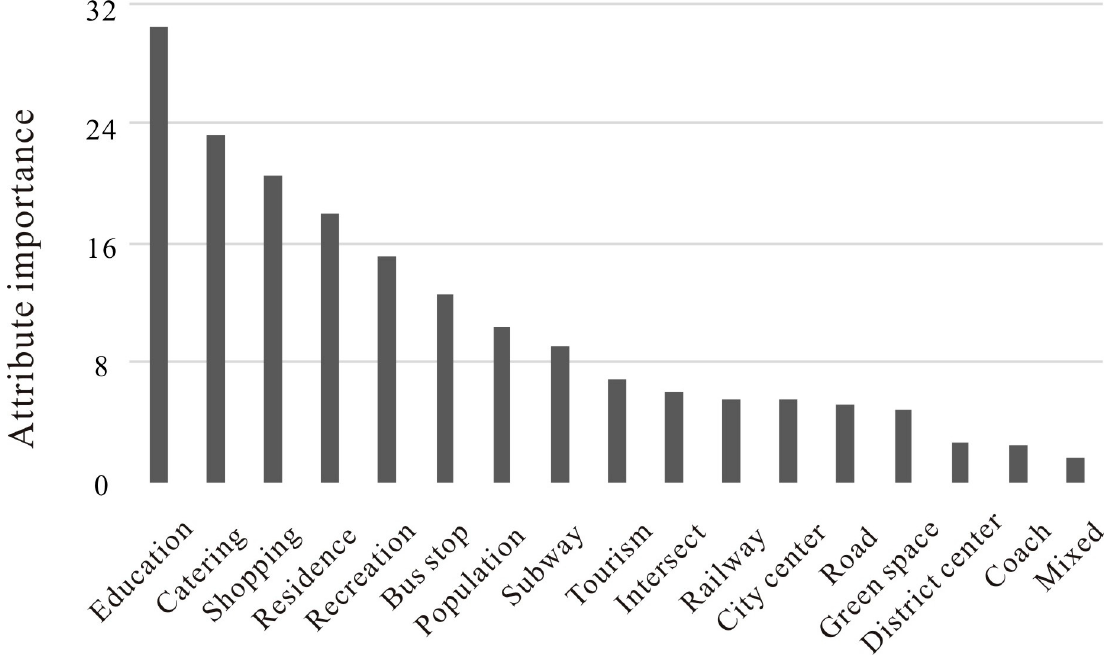
Figure 6. Permutation importance of every potential driver to urban vitality (benchmark model).